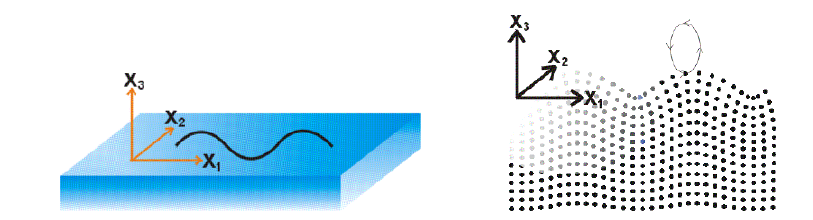
Figure 4. Surface acoustic waves: coordinate system (left) and Rayleigh wave